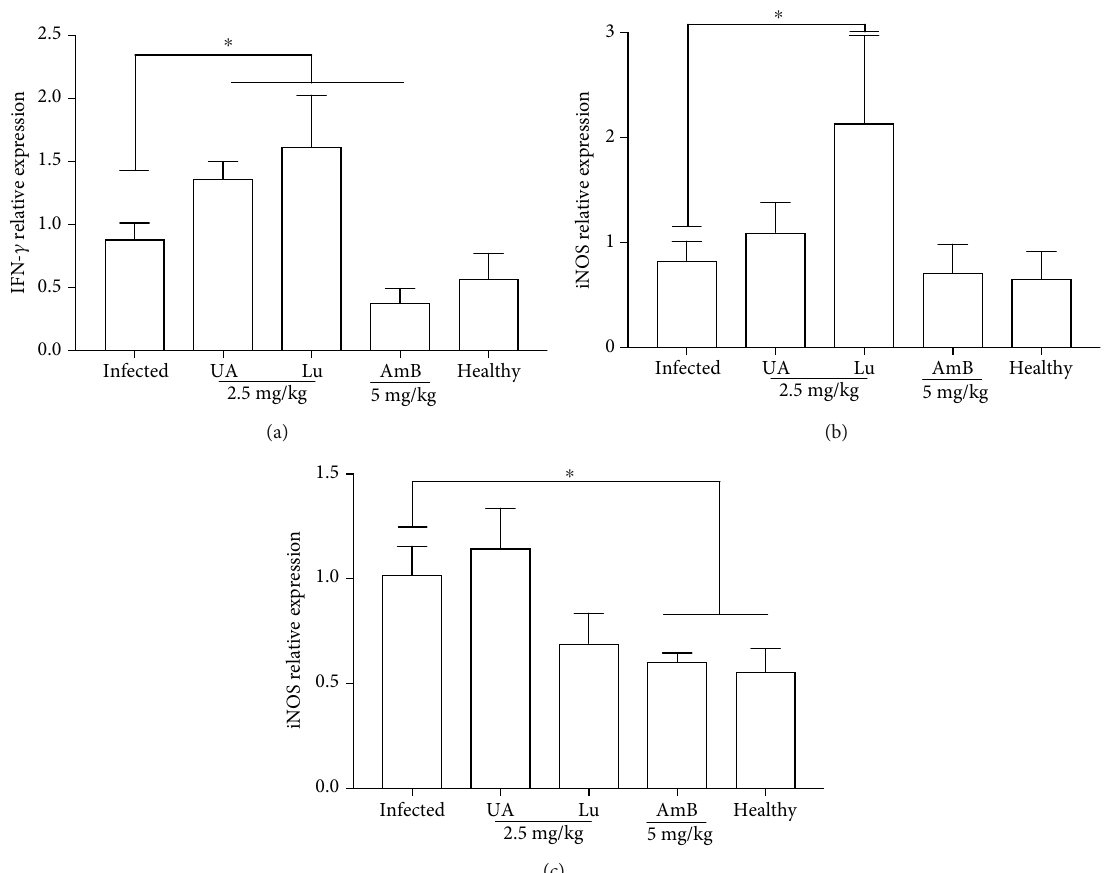
Figure 9: Cell immune response of hamsters infected with L. ( L. ) infantum and treated with triterpenes and amphotericin B. IFN- γ (a), iNOS (b, and IL-10 (c) relative gene expression in the spleen of infected golden hamsters treated with 2.5 mg/kg of ursolic acid (UA) or lupeol (Lu) and 5 mg/kg of amphotericin B (AmB). Relative gene expression was estimated by quantitative PCR. The expression levels of genes of interest were normalized to β -actin. ∗ p < 0 : 05 indicates statistical signi fi